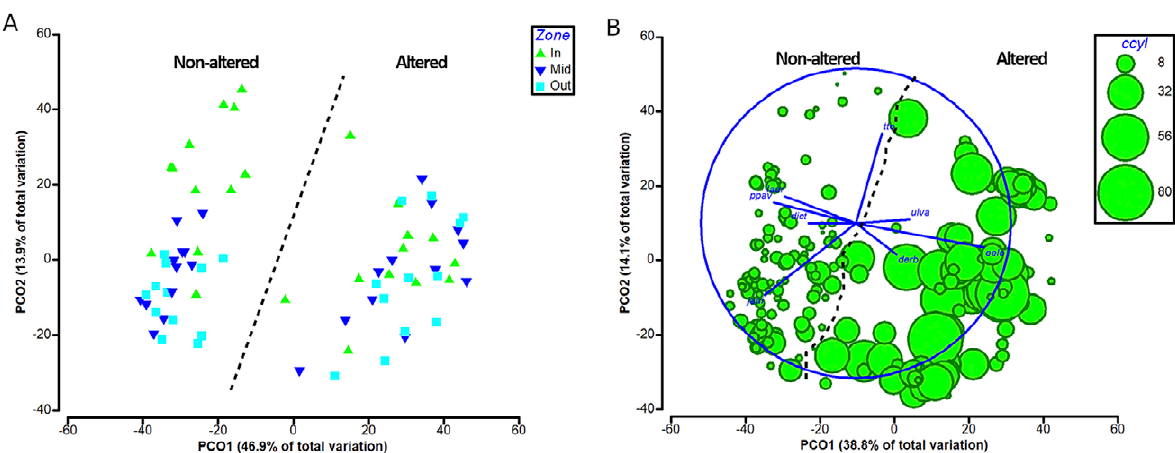
Fig. 4. – Principal coordinates ordination (PCO) of all inventories based on a Bray-Curtis similarity matrix of square-root transformed percent cover values of each taxa. Non-degraded location samples are separated from the degraded ones by a dotted line. A, PCO resulting from pooling replicates and sites by calculating the distance between centroids and showing zone adscription for each inventory. B, PCO without pooling showing the vector overlay of taxa with a correlation higher than 0.3 with the PCO axes. The percentage cover of C. cylindracea is also represented through a bubble plot. Taxa legend: eelo , E. elongata ; derb , D. tenuissima ; dict , Dictyota spp.; jani , Jania spp.; laur , Lauren- cia complex ; ppav, P. pavonica; tto , turf-forming thalli; ulva, U. laetevirens